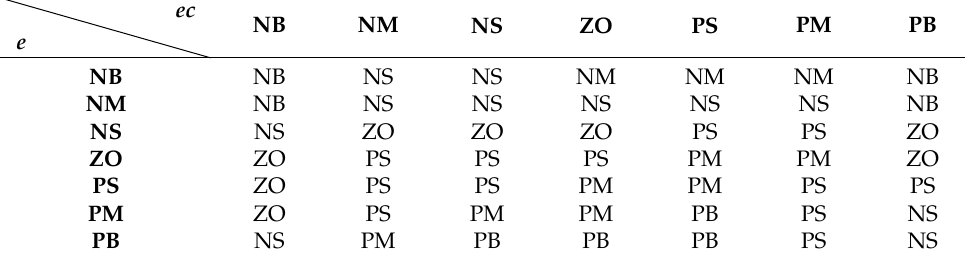
Table 2. The fuzzy control rules table of ∆ k d